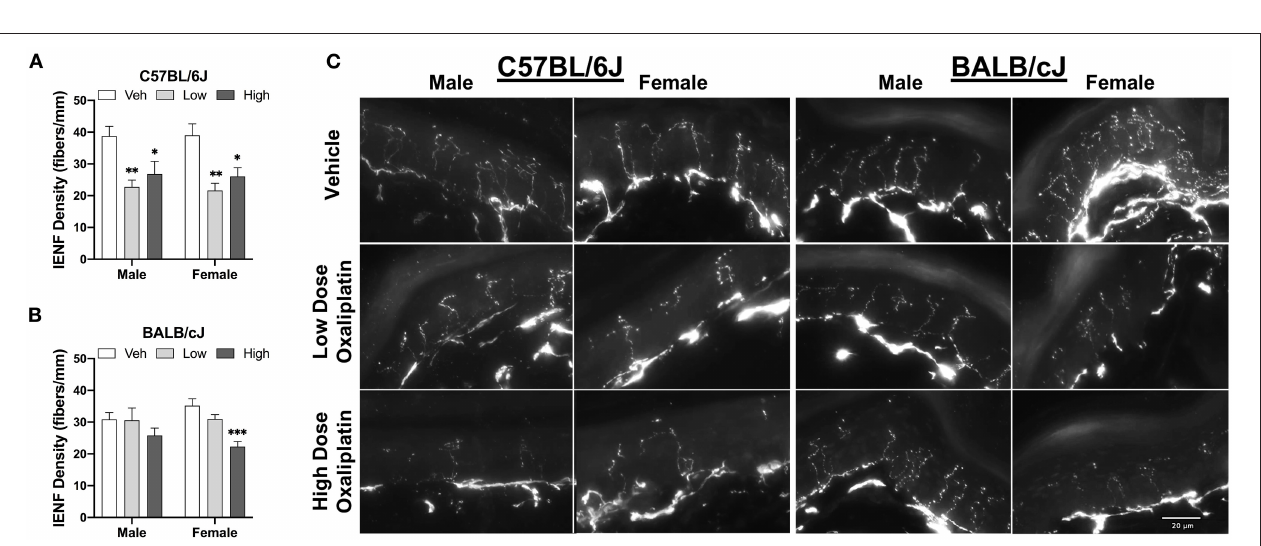
FIGURE 9 | Electrophysiological analysis of the caudal sensory nerves. One-week post completion of oxaliplatin or vehicle treatment, sensory nerve conduction amplitude (A–D) and velocity (E–H) were measured in C57BL/6J males and females ( n = 8/group) and BALB/cJ males and females ( n = 7–10/group). Values are expressed as mean ± SEM. Overall effect of oxaliplatin treatment per sex of each strain was identified using two-way ANOVA and post-hoc Tuckey’s test (*** p < 0.001).